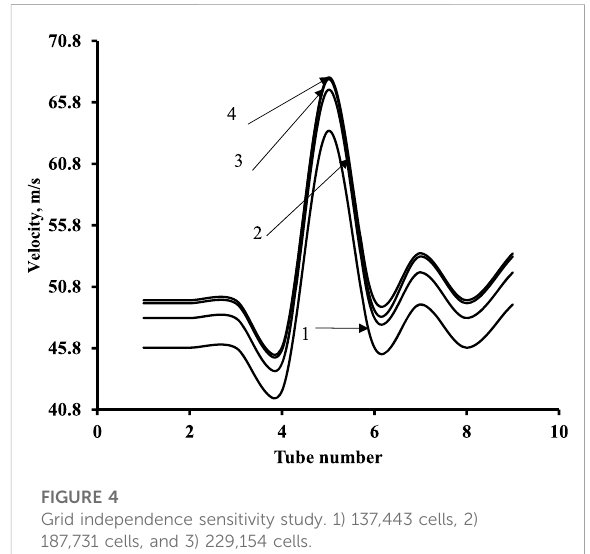
FIGURE 4 Grid independence sensitivity study. 1) 137,443 cells, 2) 187,731 cells, and 3) 229,154 cells.